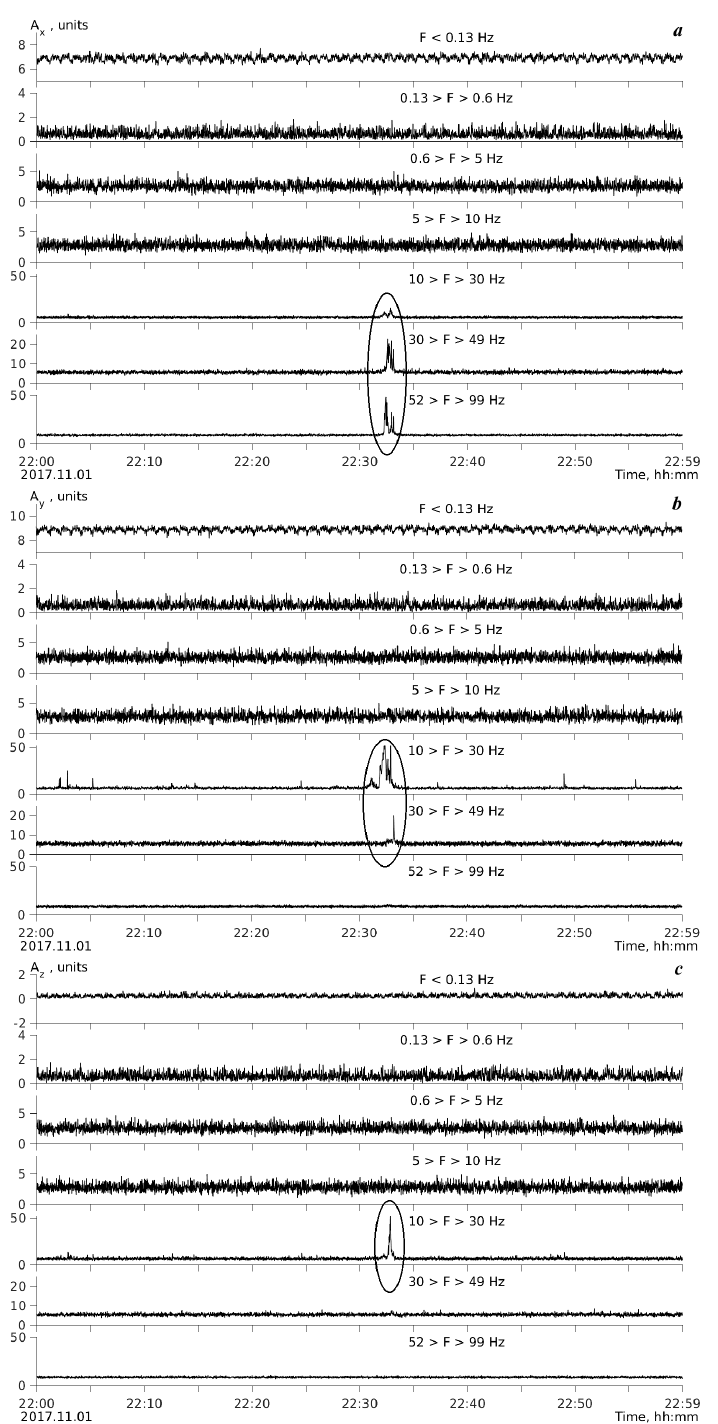
Figure 3: Geoacoustic signal variations A x , A y , A z recorded by the three-component geophone from 22:00 to 23:00 UT on November 1, 2017. The components: X (a), Y (b), Z (c). Ellipses show amplitude pulse jump which was also recorded in microbarometer signal (Fig. 2)